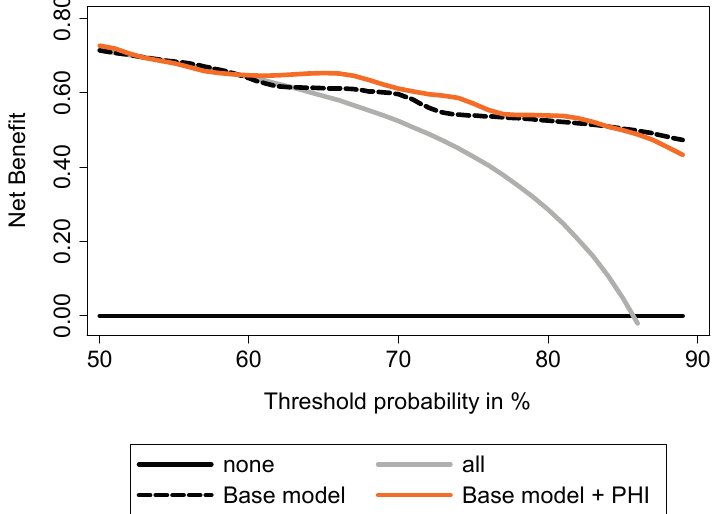
Figure 5. Evaluation of the ability of PHI to predict Gleason sum ≥ 7 using decision curve analysis. Base model: age, DRE findings, total serum PSA and Gleason sum at biopsy.